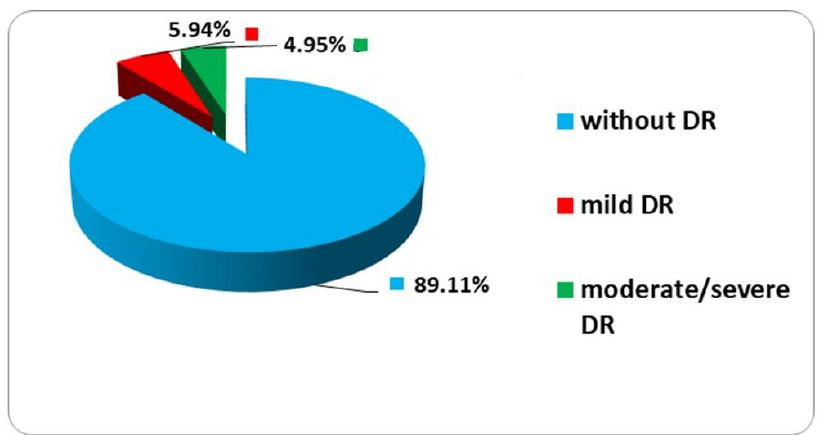
Figure 2. Distribution changes in diabetic retinopathy. DR (diabetic retinopathy) moderate, mild and severe; without diabetic retinopathy.